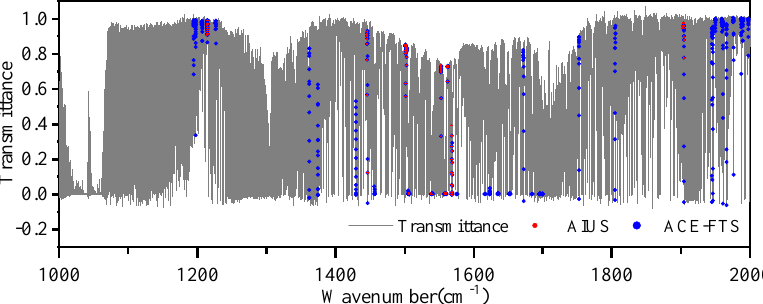
Figure 8. The comparison of micro-windows between AIUS and